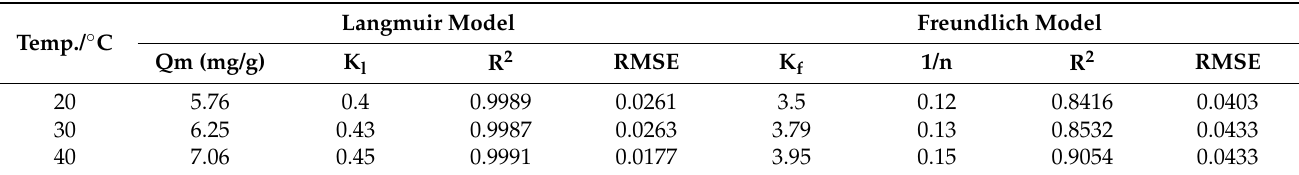
Table 5. Fitting parameters of adsorption isotherm model for Cd ion.